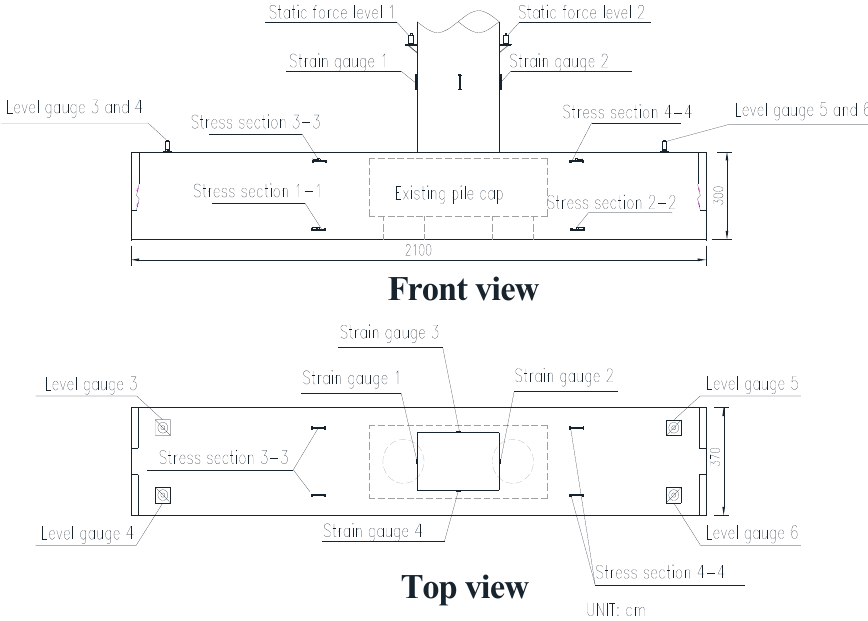
Figure 11. Monitoring sensor arrangement of the underpinning pile